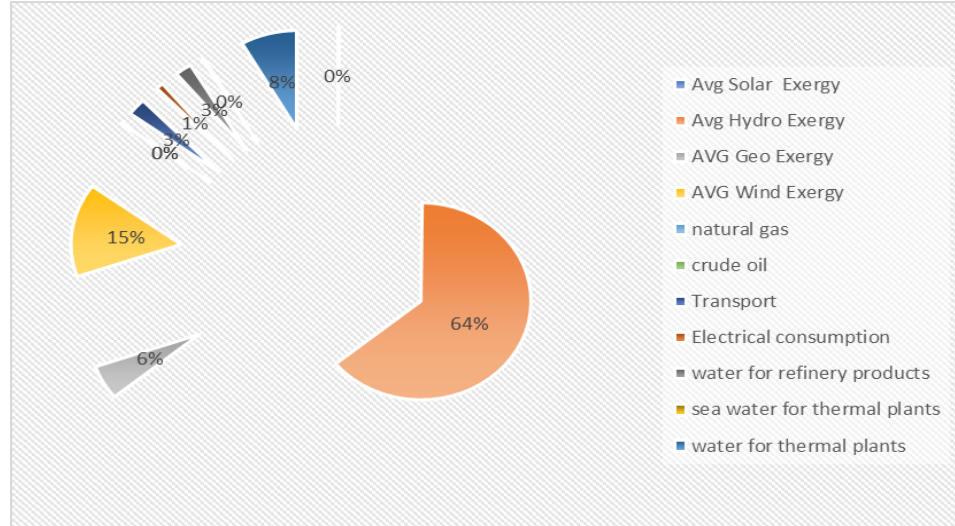
Figure 6. Exergy inputs of the Italian CO sector according to the proposed EE model (2017 data).